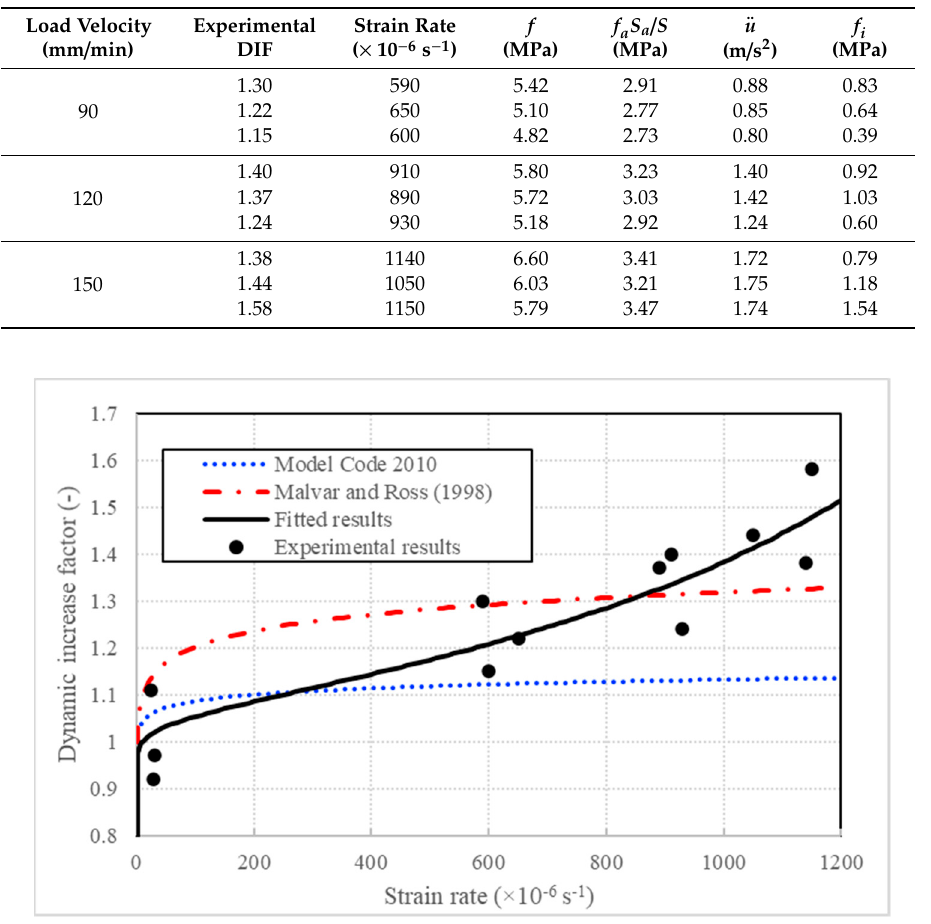
Table 5. Contribution of aggregate and dynamic inertia to the concrete strength under dynamic conditions. (DIF: dynamic increase factor, f is the dynamic strength, strength contributed by the inerita).